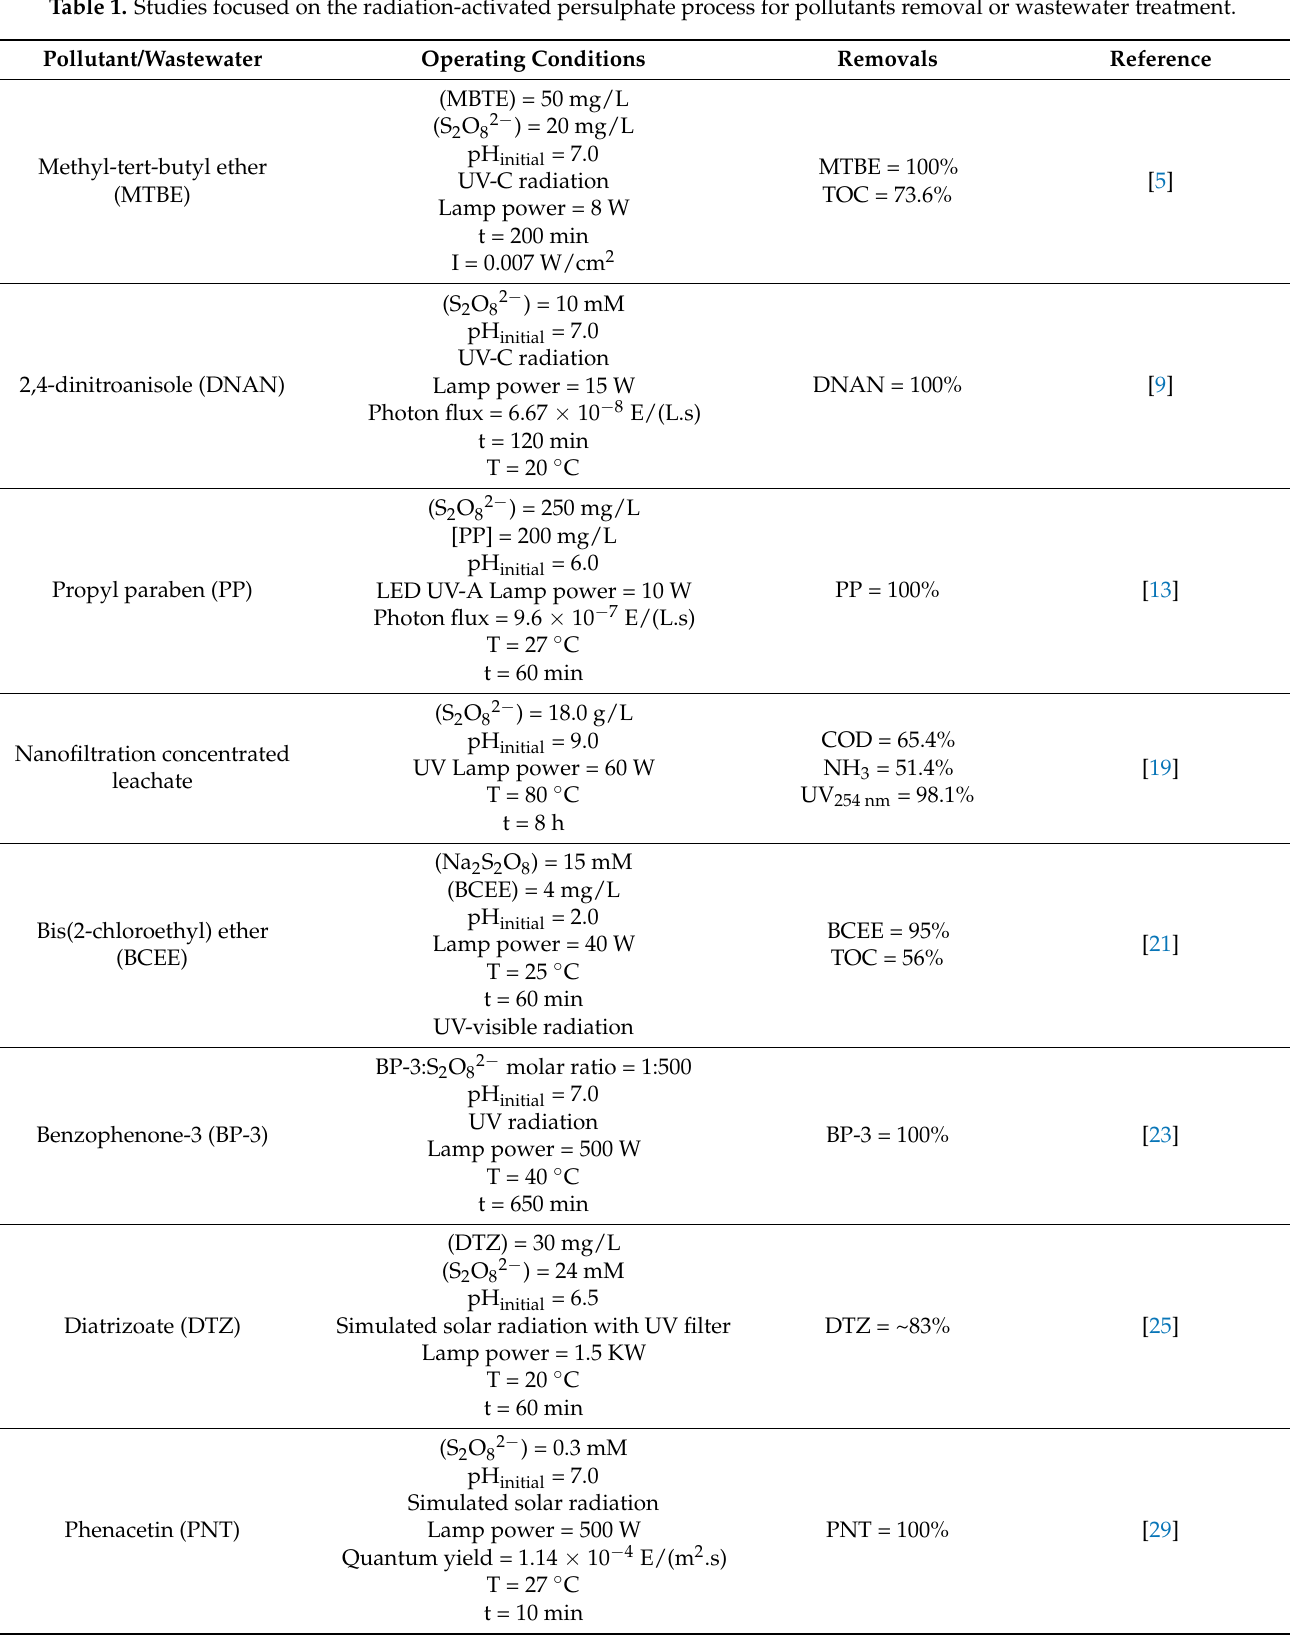
Table 1. Studies focused on the radiation-activated persulphate process for pollutants removal or wastewater